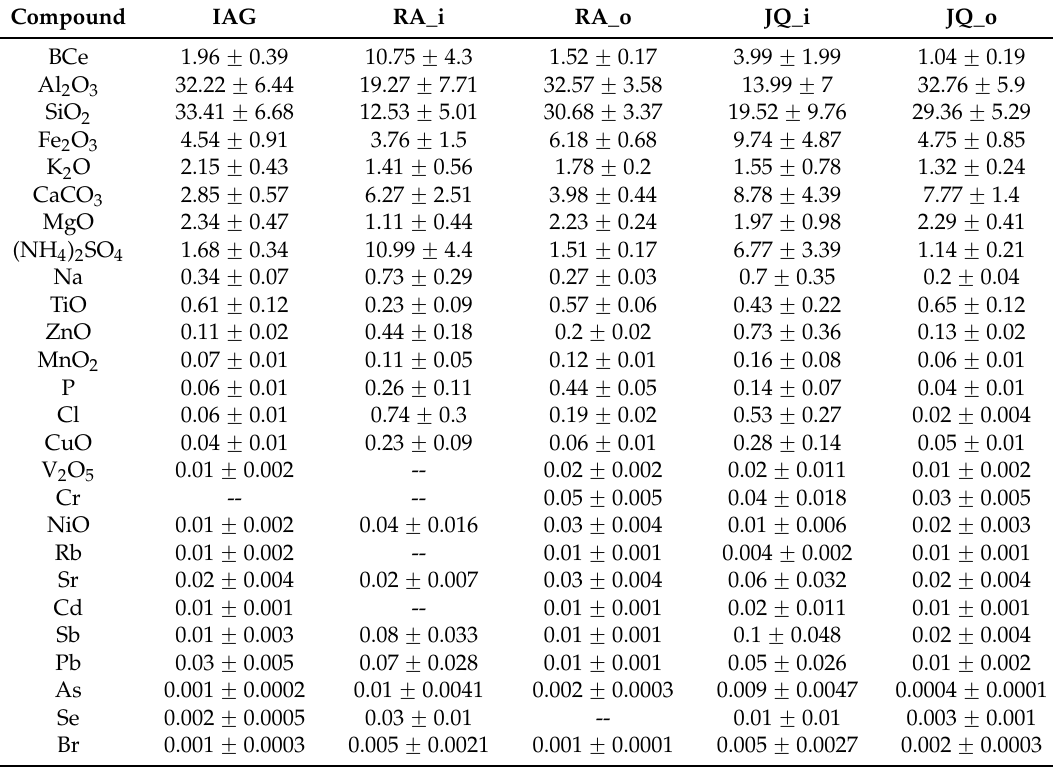
Table 2. Composition of the road dust as a percentage of the total mass of the resuspended material collected on the Teflon filters in the resuspension